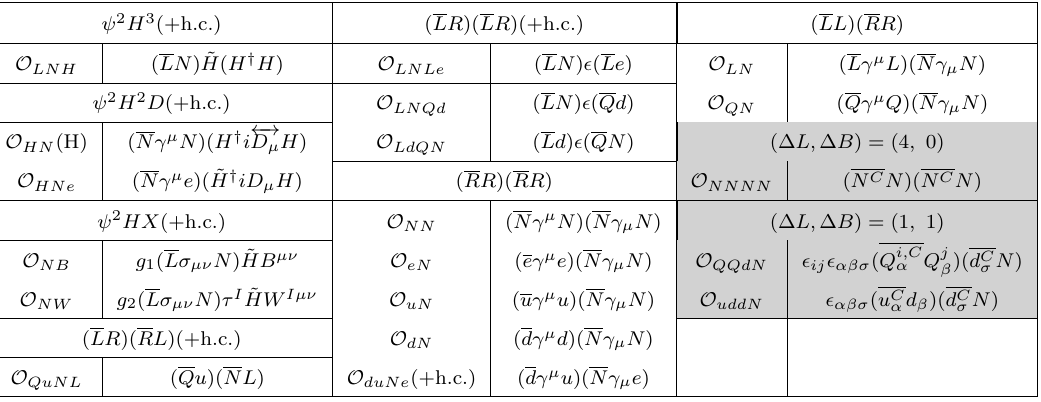
Table 8 . The basis of dim-6 operators involving RH neutrino N in SMNEFT [7], where (cid:11); (cid:12); (cid:27) and i; j are SU(3) C and SU(2) L indices, respectively.